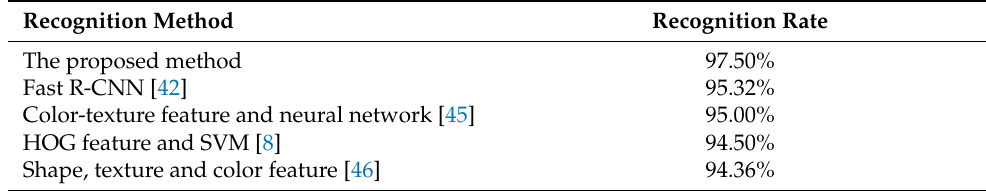
Figure 12. ( a ) Several images in the NUS dataset. ( b ) The rotated images. Table 5. Comparison results on the NUS